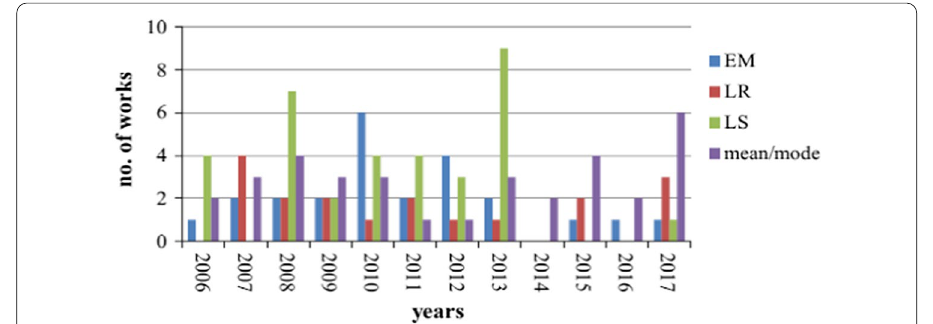
Fig. 2 Distribution in the number of studies using EM, LR, LS, and mean/mode techniques